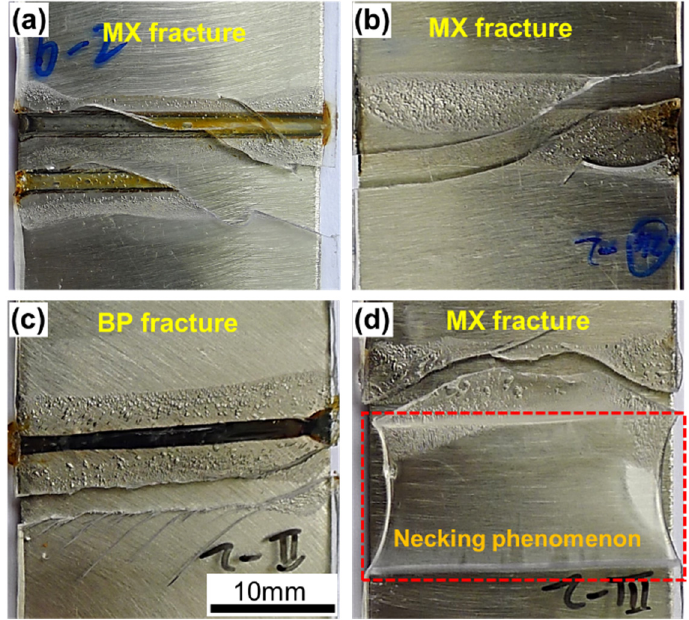
Figure 4. Macroscopic fracture morphologies: ( a ) LTJ, ( b ) O-LTJ, ( c ) LCJ, ( d ) O-LCJ, where “MX fracture” denotes the sample cracks in mixed mode; “BP fracture” denotes the sample cracks along PET.